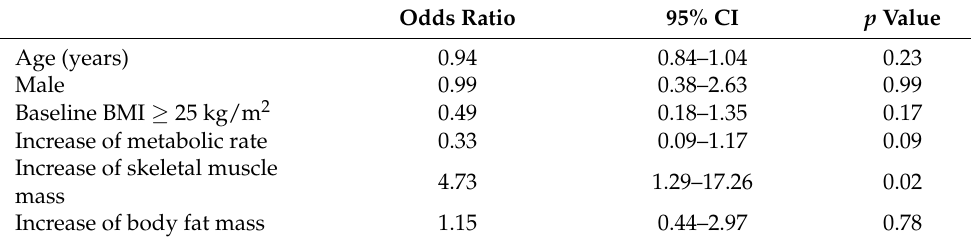
Table 2. Multivariate factors related to the rise in body